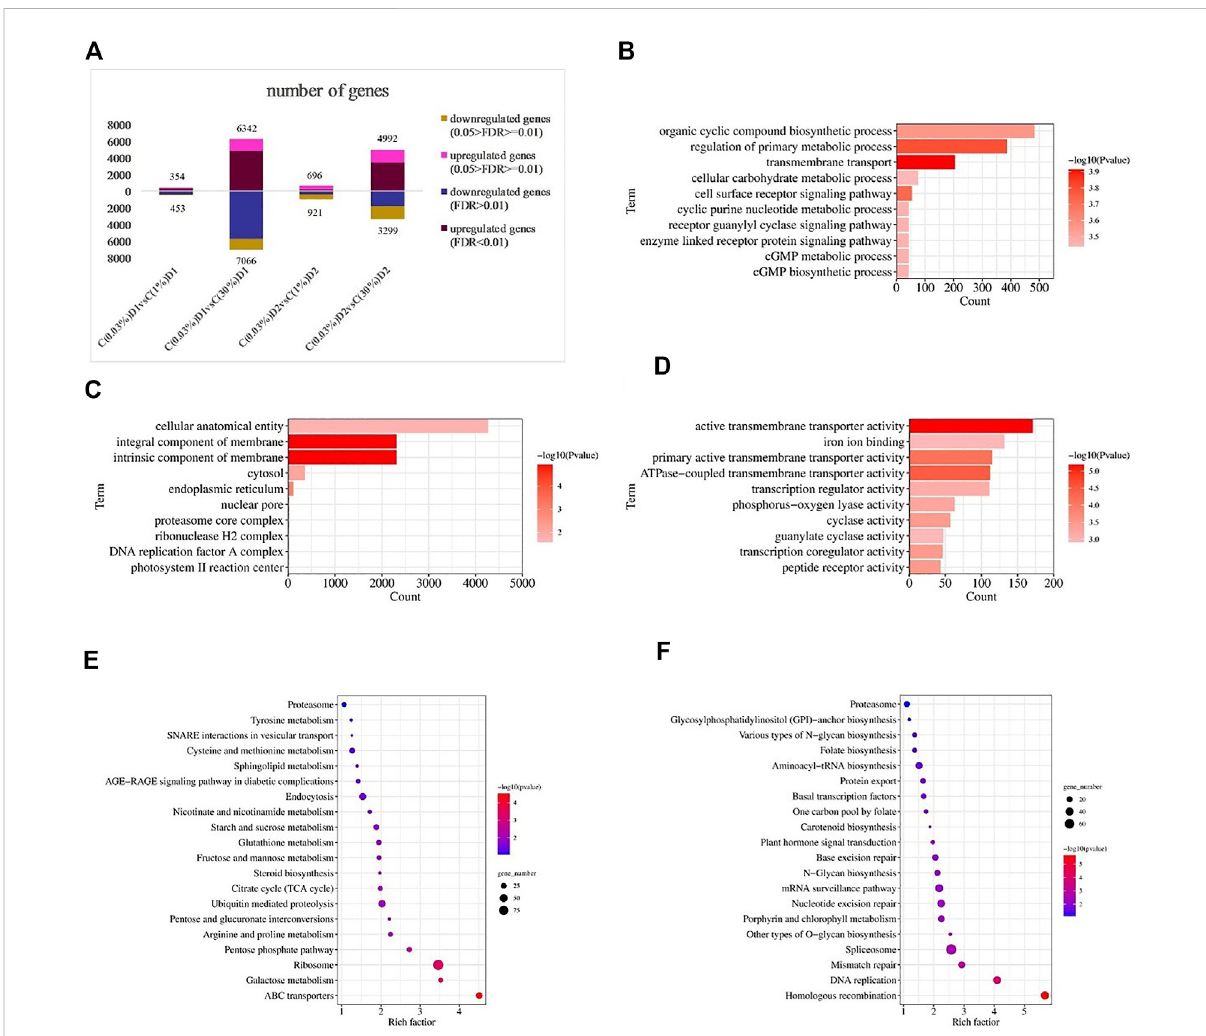
FIGURE 2 Transcriptional responses of D. salina to high CO 2 stress. Number of differentially expressed genes (DEGs) between different CO 2 treatment groups (A) . Distribution of top GO categories enrichment under 0.03% and 30% CO2 treatment (1 day): (B) (biological processes), (C) (cellular components) and (D) (molecular functions). Distribution of top KEGG metabolic pathways enrichment under 0.03% and 30% CO 2 treatment (1 day): (E) (up-regulated genes) and (F) (down-regulated genes). Enrichment was analyzed based on hypergeometric test and Bonferroni adjustment (corrected p -value ( P -adjust) <